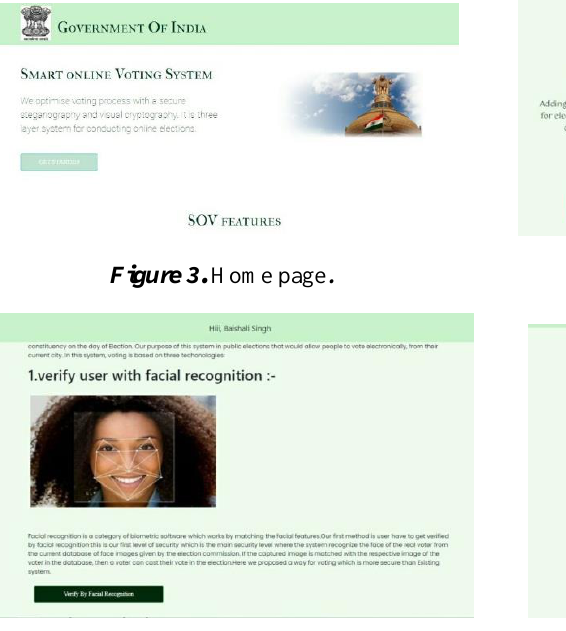
Figure 5. Verify by facial recognition . Figure 6. Verify manually